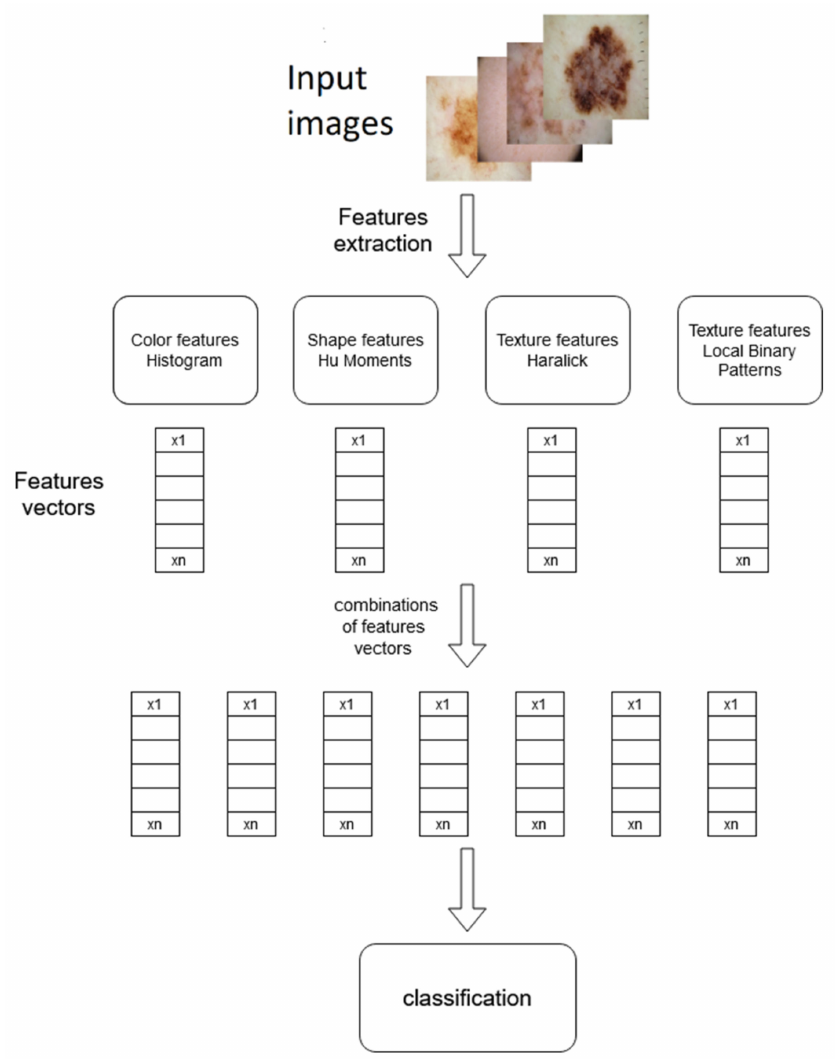
Figure 2. Flowchart of proposed